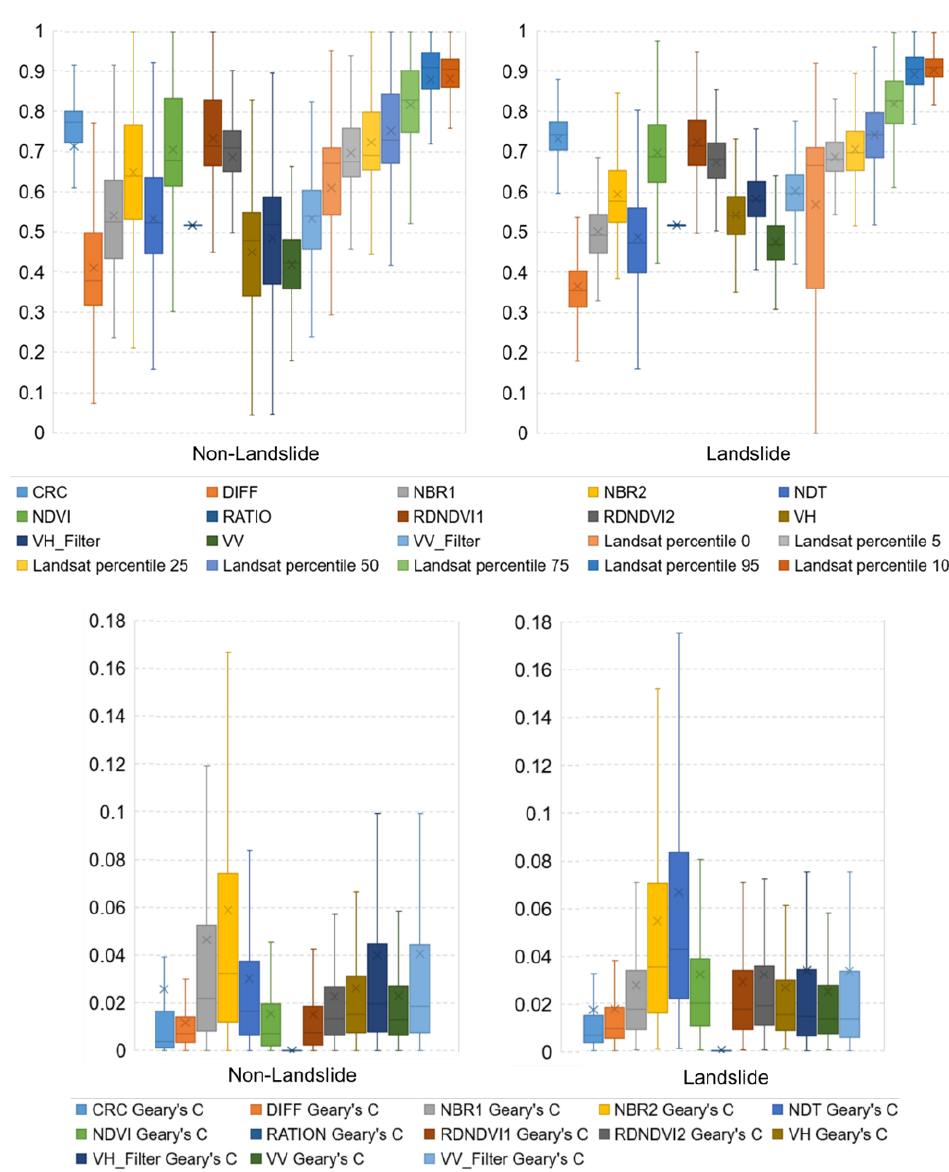
Figure 5. Statistical box plots of dynamic factors.